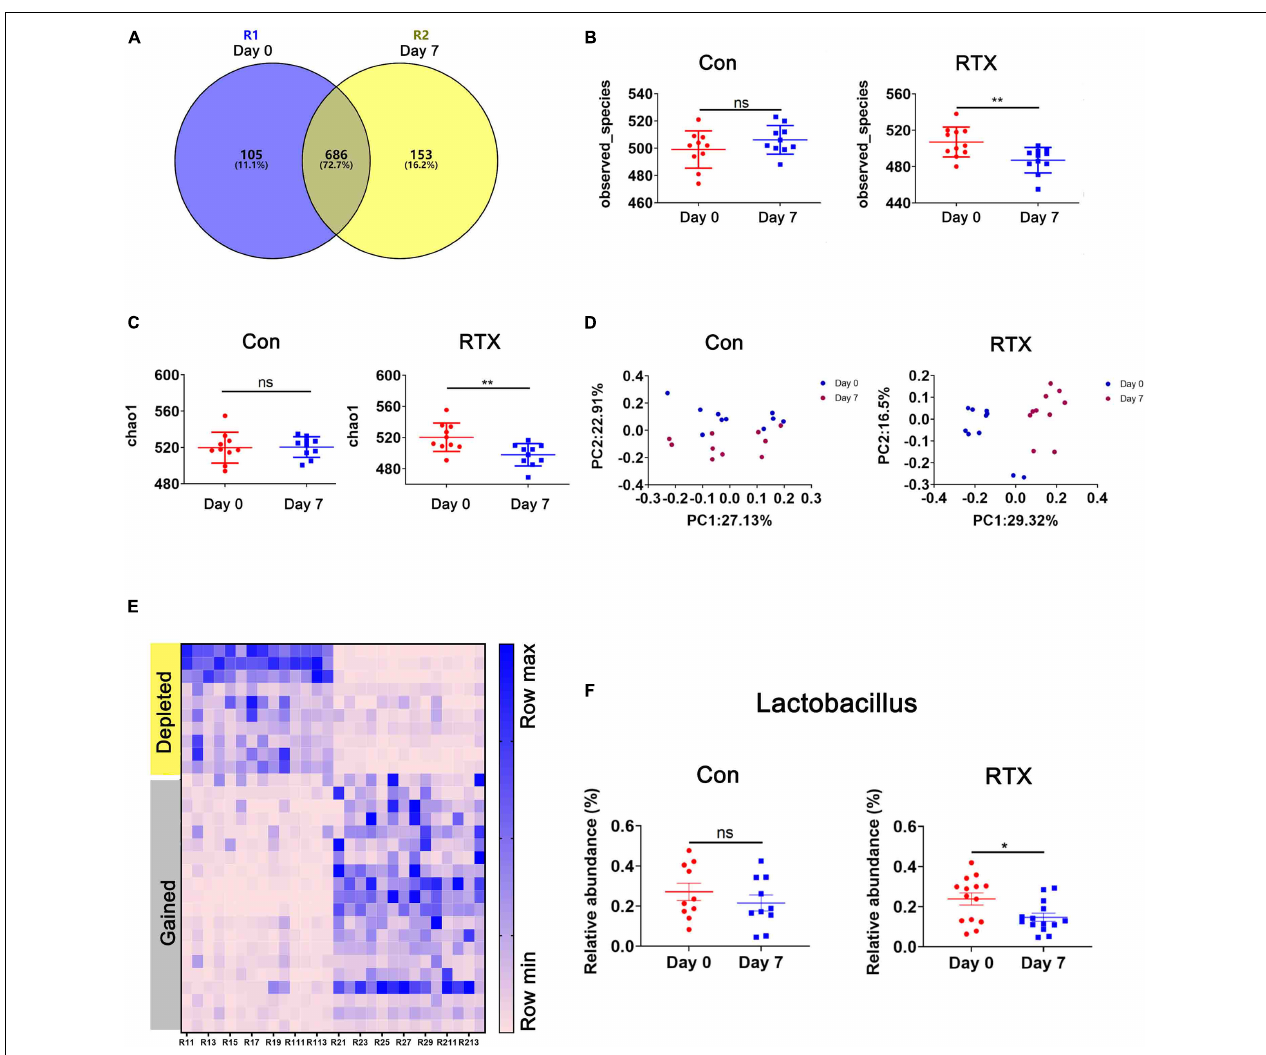
FIGURE 3 | Rituximab treatment changes the composition of the intestinal microbiota. (A) The number of OTUs in the intestine of RTX-treated mice on day 0 (blue), day 7 (yellow), or shared on days 0 and 7 (gray). (B,C) Changes in the α diversity of the intestinal microbiota in the RTX-treated and control groups are shown on days 0 and 7. (D) The results of principal component analysis (PCA) of intestinal microbiota in the RTX-treated group and control group on days 0 and 7. (E) Heatmap of OTUs of intestinal microbiota in RTX-treated mice on days 0 and 7. (F) The relative abundance of 2 examples of OTUs in RTX-treated mice and control mice. OTUs, operational taxonomic units. * p < 0.05, ** p <